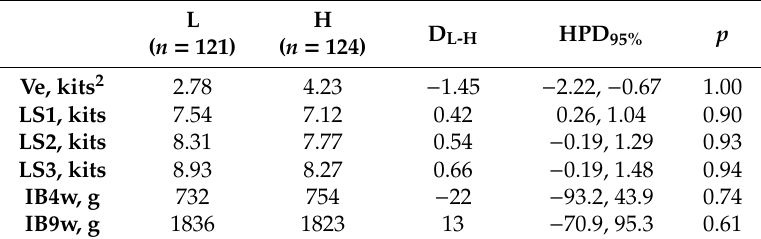
Table 1. Features of the marginal posterior distribution of the differences for litter size residual variance at birth (Ve), litter size at first (LS1), second (LS2) and third (LS3) parity, and individual body weight at 4 weeks (IB4w) and at 9 weeks old (IB9w) in rabbits.